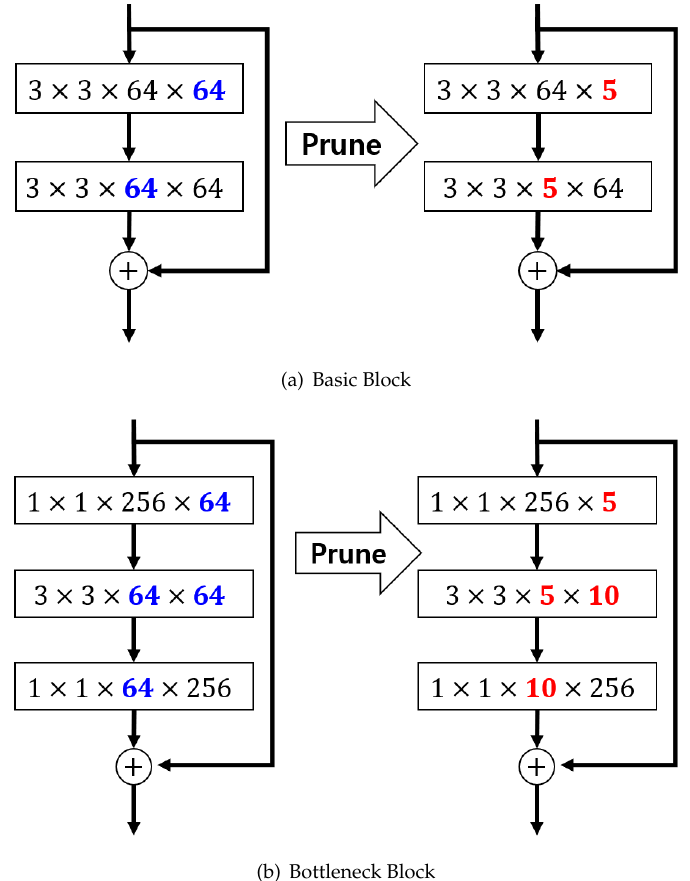
Figure 4. An example of a pruning ResNet. The red values are the number of remaining